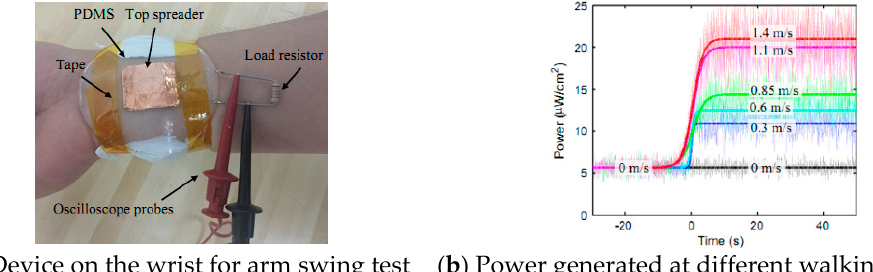
Figure 2. Thermoelectric generator attached onto the upper arm [7].